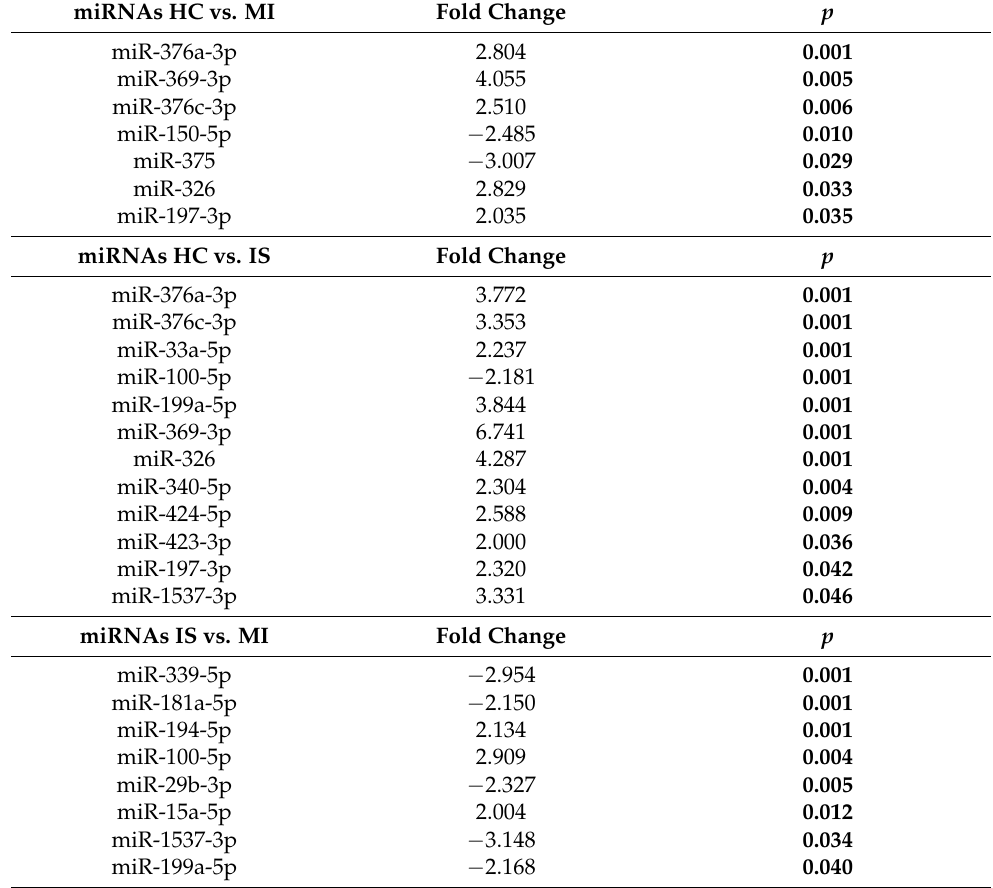
Table 4. MiRNA candidates for validation. miRNAs HC vs. MI Fold Change